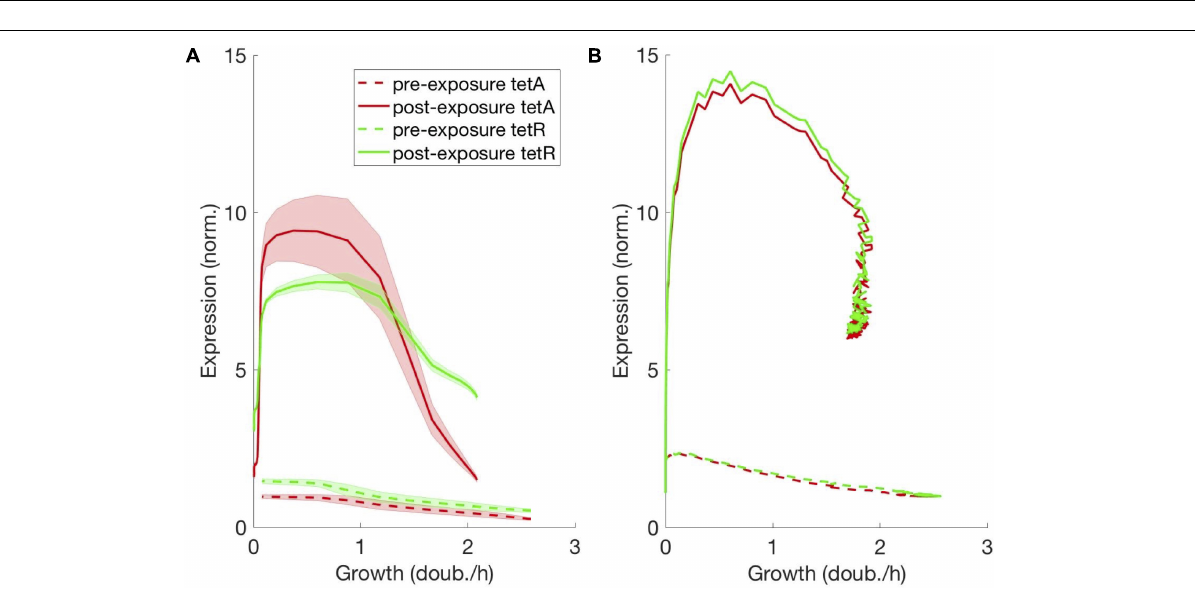
FIGURE 5 | Sequence of exposures to tetracycline builds up resistance among slow-growing cells below the boundary. (A) Cell growth, (B) TetA and TetR expression at a fixed depth of 50 µ m during a sequence of exposures to tetracycline, with pulses of 5, 10, 20, and 60 min delivered every 2 h. Cell growth decreases upon each drug exposure for about 2 h, regardless of exposure duration, but later recovers. TetA and TetR expression increase following each exposure, but later return to pre-exposure levels. (C) Cell growth, (D) TetA and TetR expression at a fixed depth of 115 µ m during a sequence of exposures to tetracycline. Transient increases in cell growth at lower depths correspond to the periods of reduced growth at the top of the trap. TetA and TetR levels increase further with each exposure. Expression levels are kept between exposures while these cells become dormant. The periods of exposure to tetracycline are depicted in pink shading.